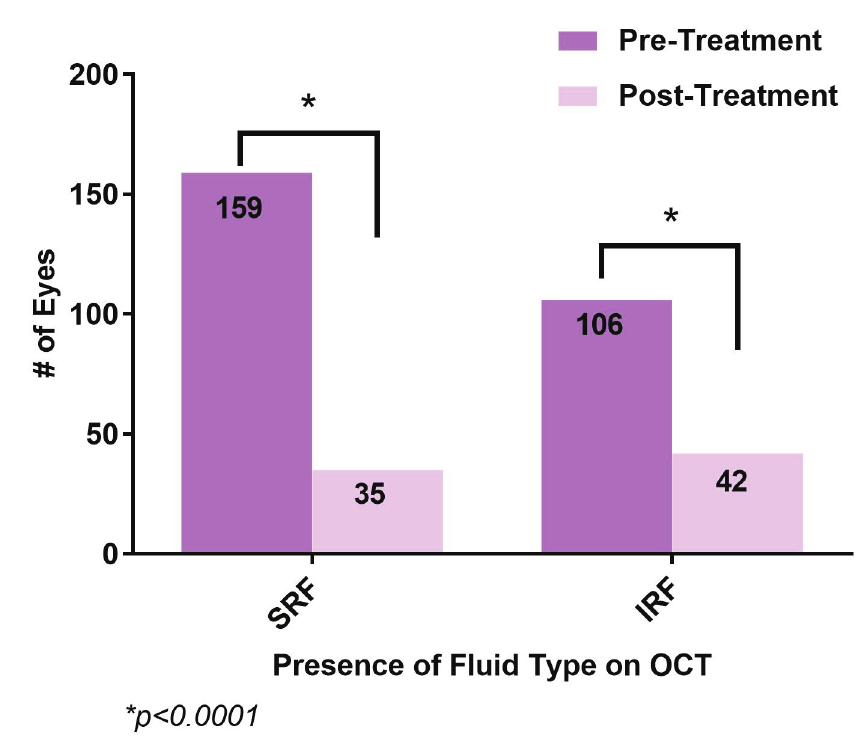
Figure 4. Comparison of OCT finding between baseline and last visit. The figure shows the number of eyes with the presence of SRF and IRF pre- and